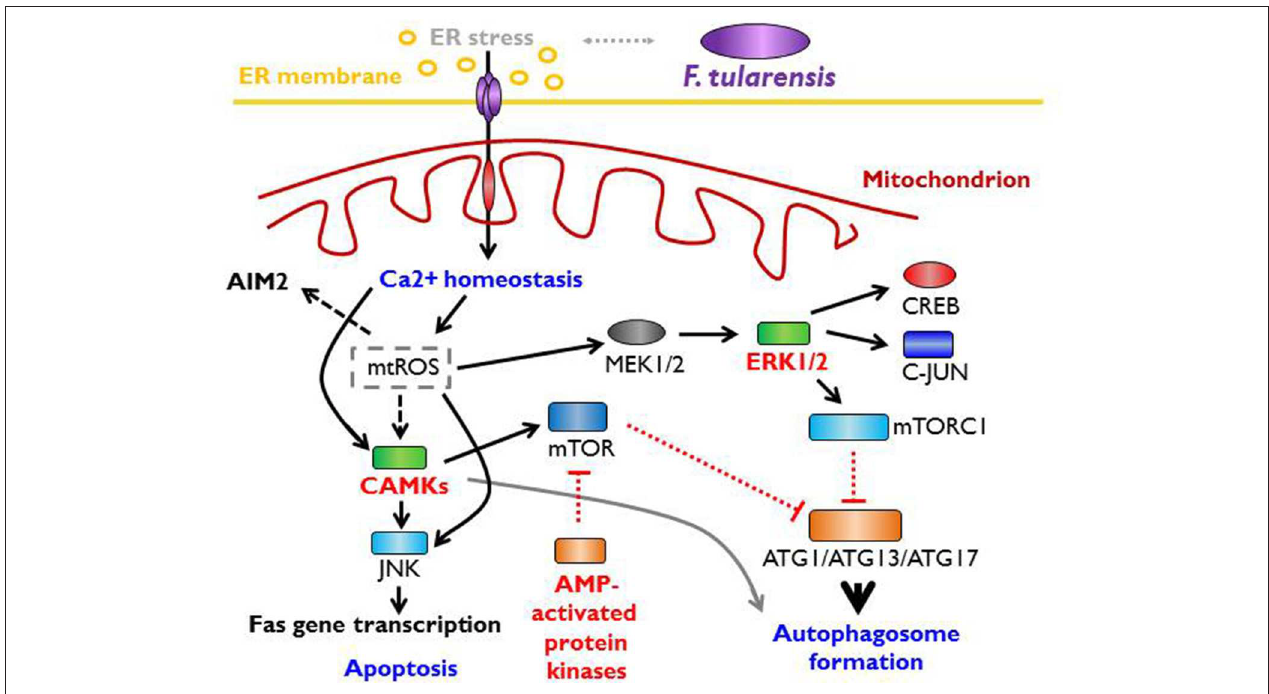
FIGURE 3 | Mitochondrial stress signaling and Francisella. Endoplasmatic (ER) stress is directly linked to autophagy and the induction of mitochondrial stress response. Stressed ER releases Ca 2 + ions that are accepted by mitochondria and results in calcium overload degenerating mitochondrial depolarization and production of mitochondrial reactive oxygen species (mtROS). This processes lead to activation of AIM2 inflammasome and the activation of signals via CAMKs (calmodulin-dependent protein kinases) that leads to the activation of apoptotic pathways or the activation of mTOR (mammalian target of rapamycin), master regulator of cell growth, metabolism, and the critical component of signaling